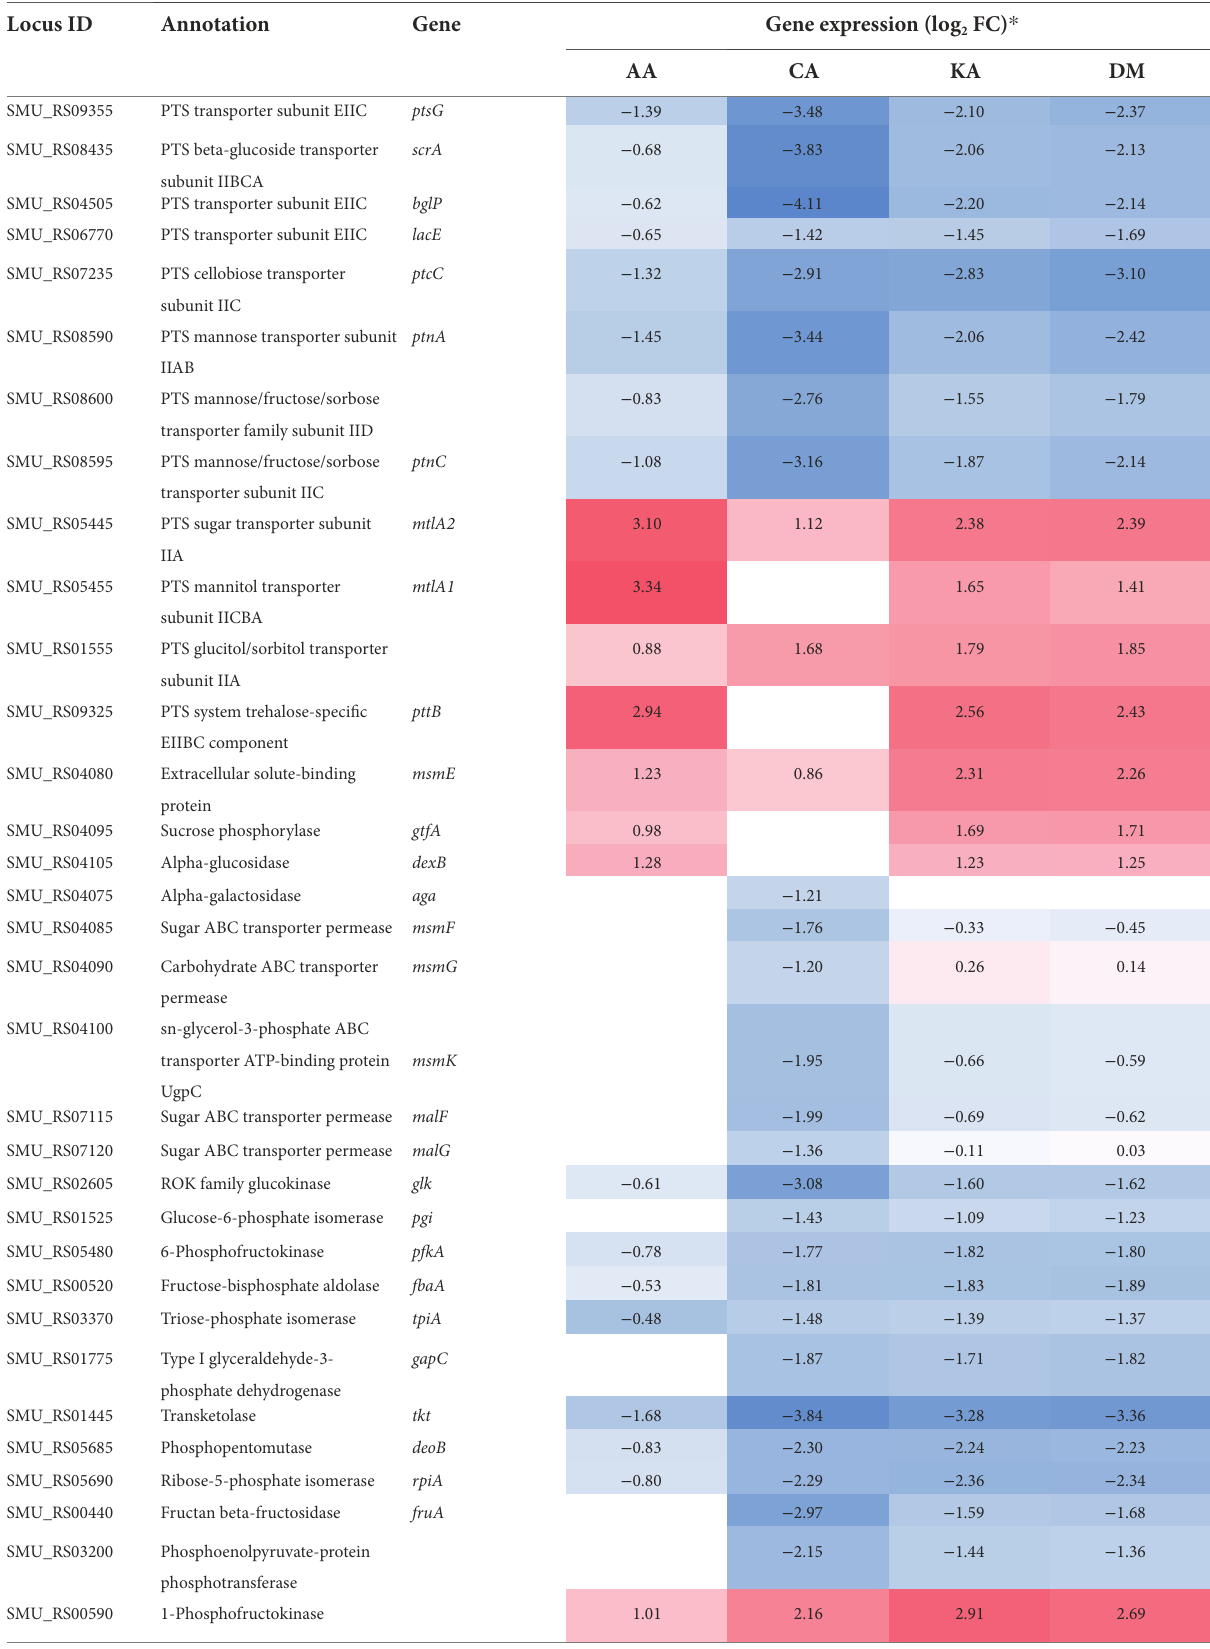
TABLE 2 Differential gene expression associated with carbohydrate uptake and metabolism. Locus